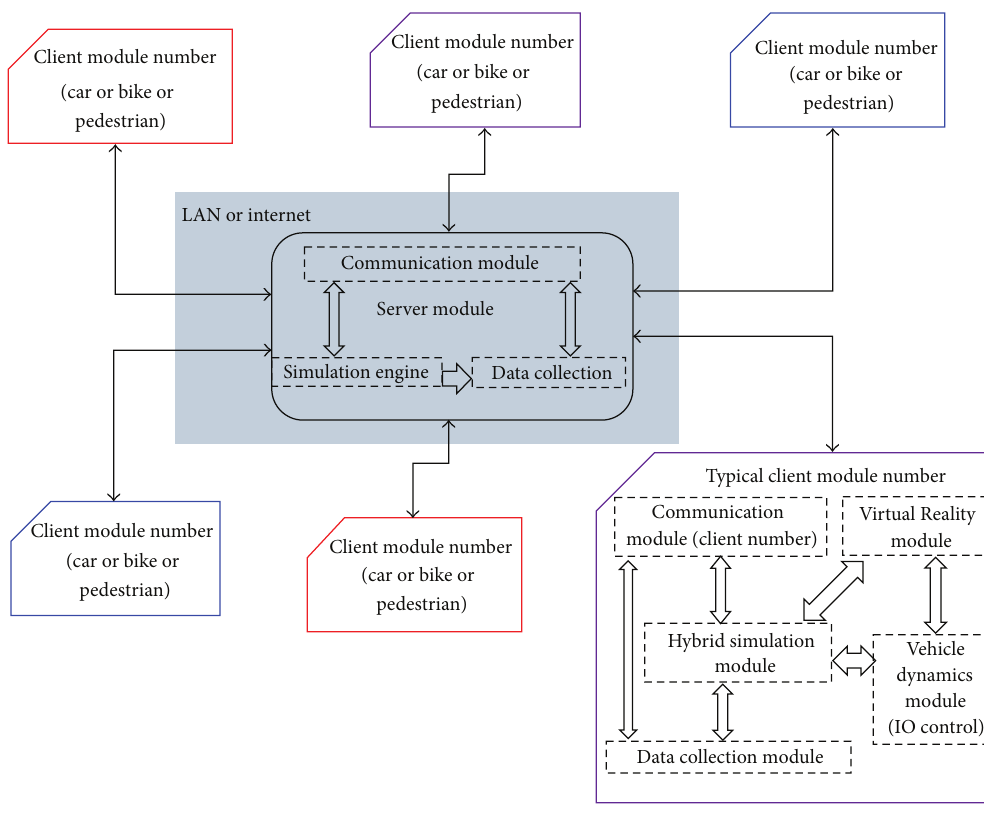
Figure 2: Data flow